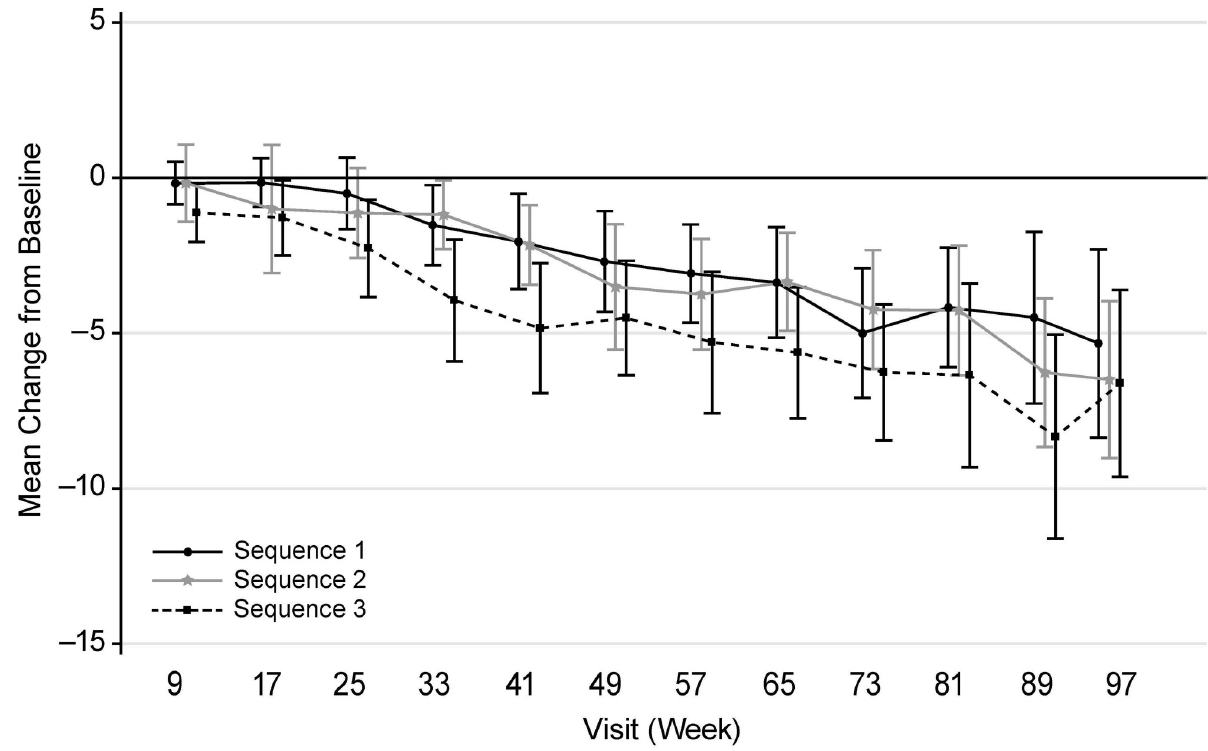
Fig 1. Mean change from baseline in NSAA total score with domagrozumab compared with placebo (full analysis set a ). CI, confidence interval; NSAA, North Star Ambulatory Assessment. a all patients who were randomized and received at least one dose of study drug.